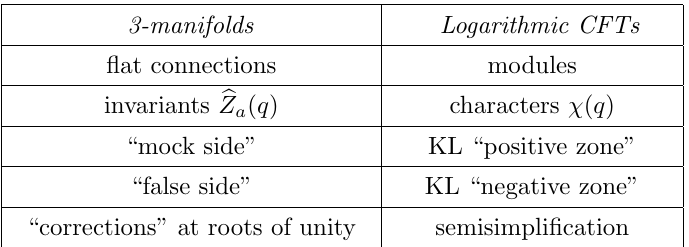
Table 1 . Mysterious duality between 3-manifolds and logarithmic